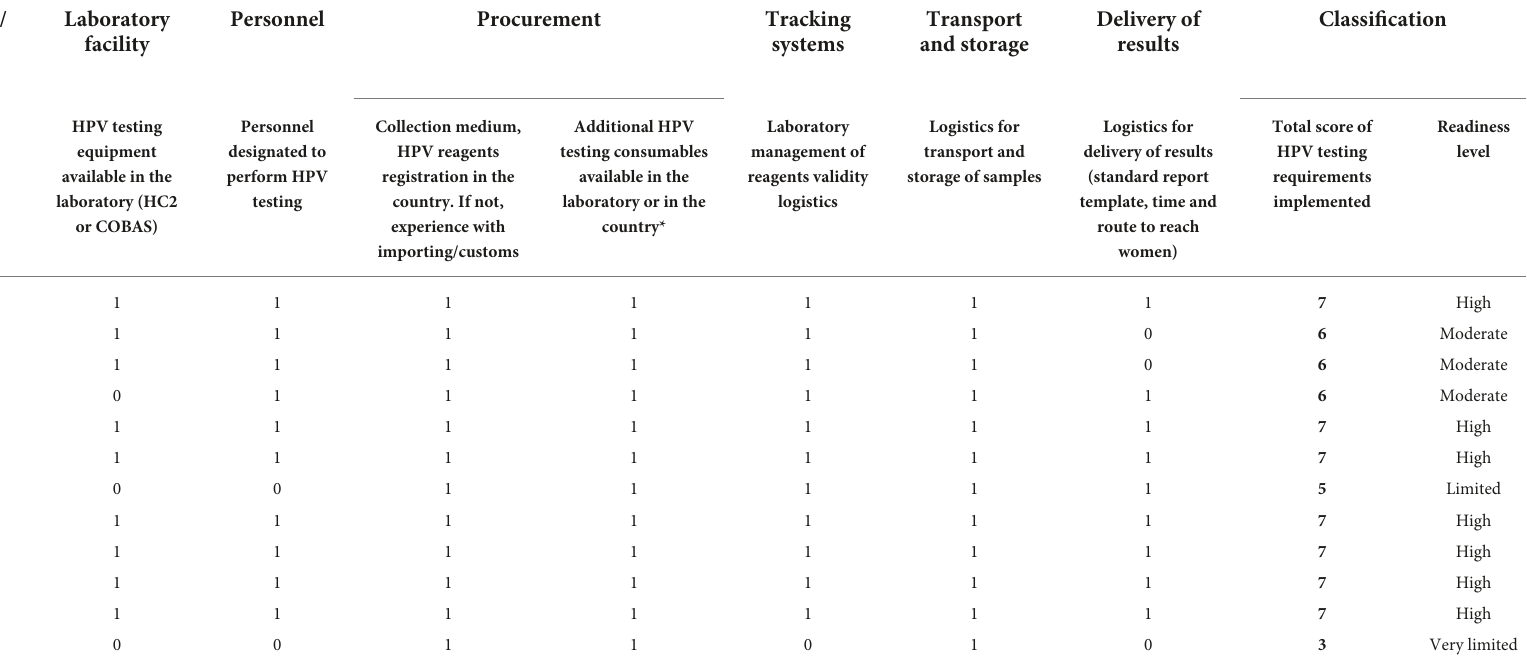
TABLE 1 Readiness of laboratories based on compliance (1 = complied, 0 = not complied) to 7 essential